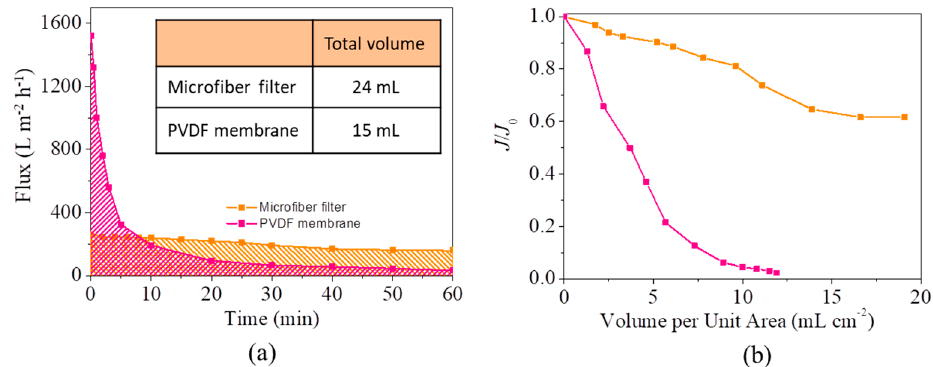
Figure 7. ( a ) Fluxes of microfiber filter and PVDF membrane decline with time (Effective area: 3.2 cm 2 ; Pressure difference: 0.4 bar). Inset shows the total volume of emulsion treated by microfiber filter and PVDF membrane in one hour; ( b ) Flux retention rate ( J / J 0 ) as a function of filtrate volume per unit area (mL cm − 2 ).